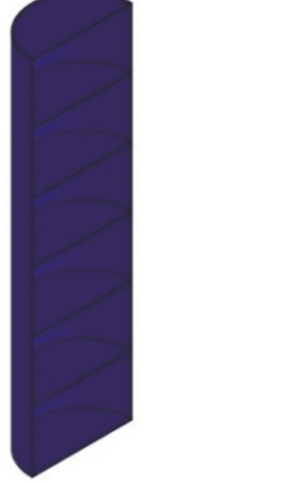
Table 2: The parameters of tower.